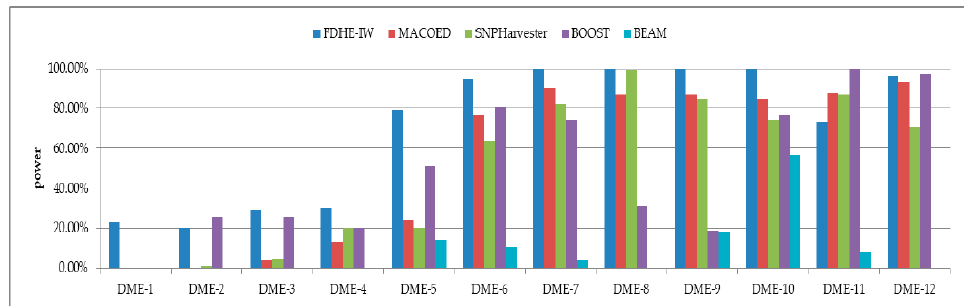
Figure 2. Detection powers of the five evaluated algorithms (100 SNPs, 1600 sample size).DME: Disease loci with marginal effects.